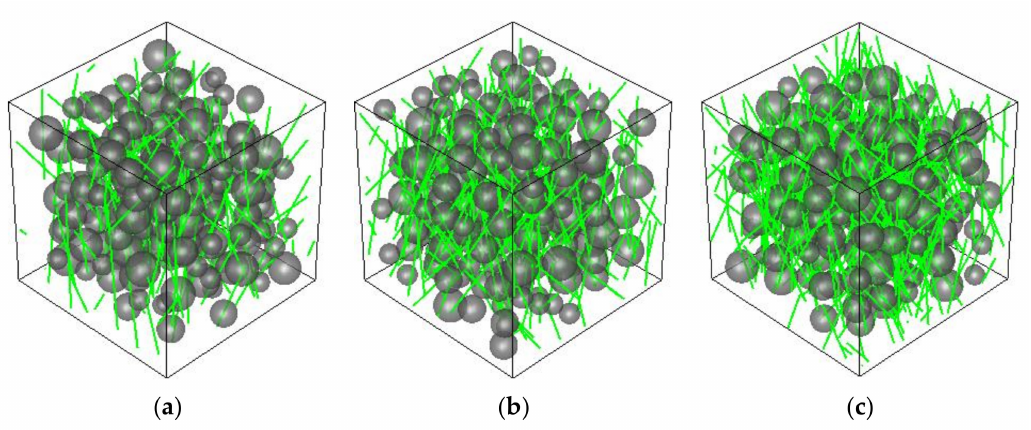
Figure 1. Virtual generation of steel fiber-reinforced concrete (SFRC) specimens with size 50 × 50 × 50 mm 3 : ( a ) V f = 0.5% and θ = 40 ◦ ; ( b ) V f = 1.0% and θ = 40 ◦ ; ( c ) V f = 1.5% and θ = 40 ◦